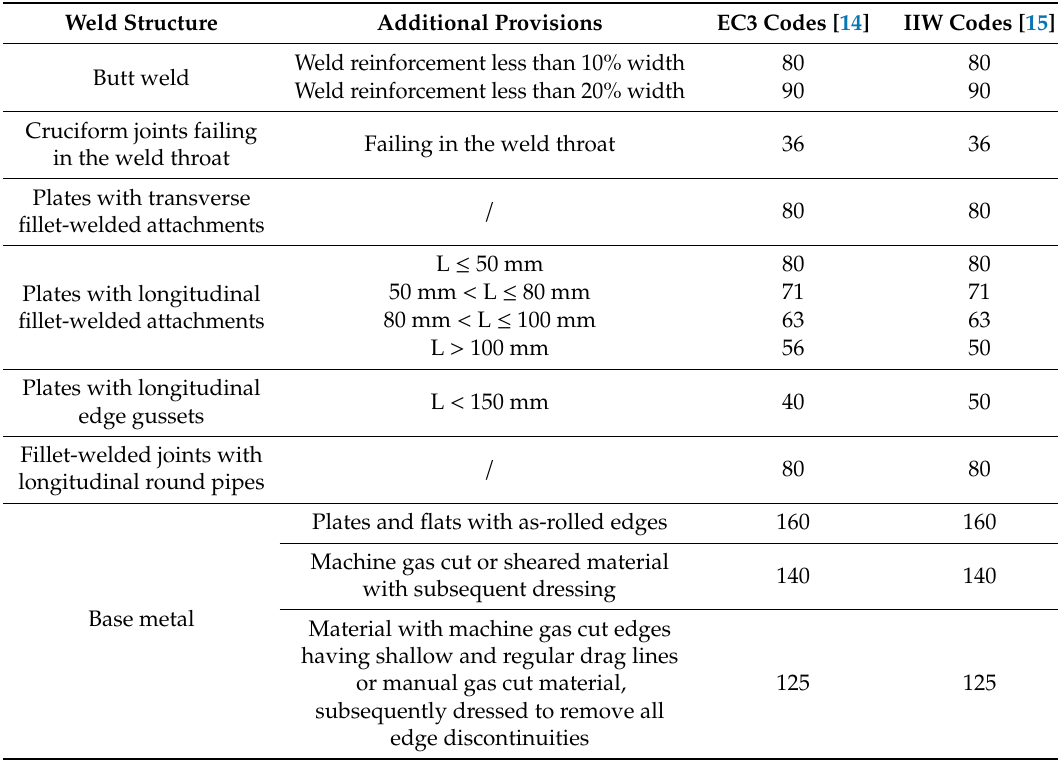
Table 1. Fatigue strength of typical welded joints in the European Eurocode (EC)3 Parts 1–9 and the International Institute of Welding (IIW)